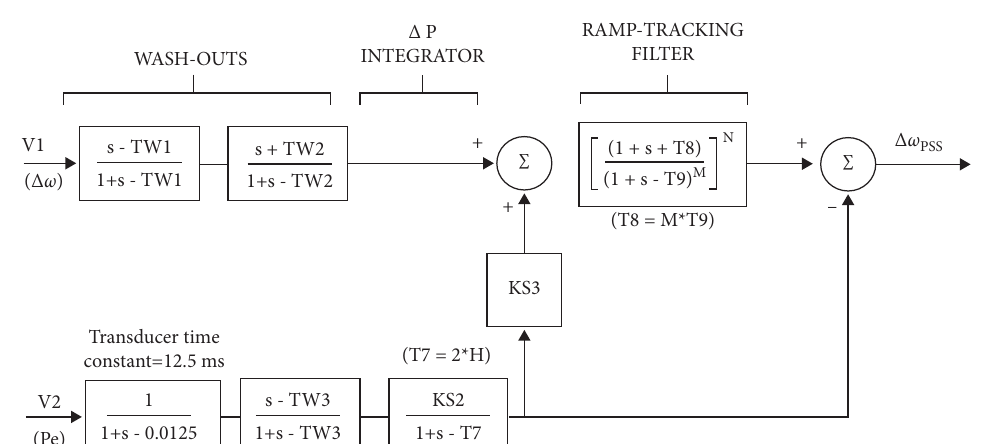
Figure 5: Block diagram of speed transformer of PSS2B stabilizer.